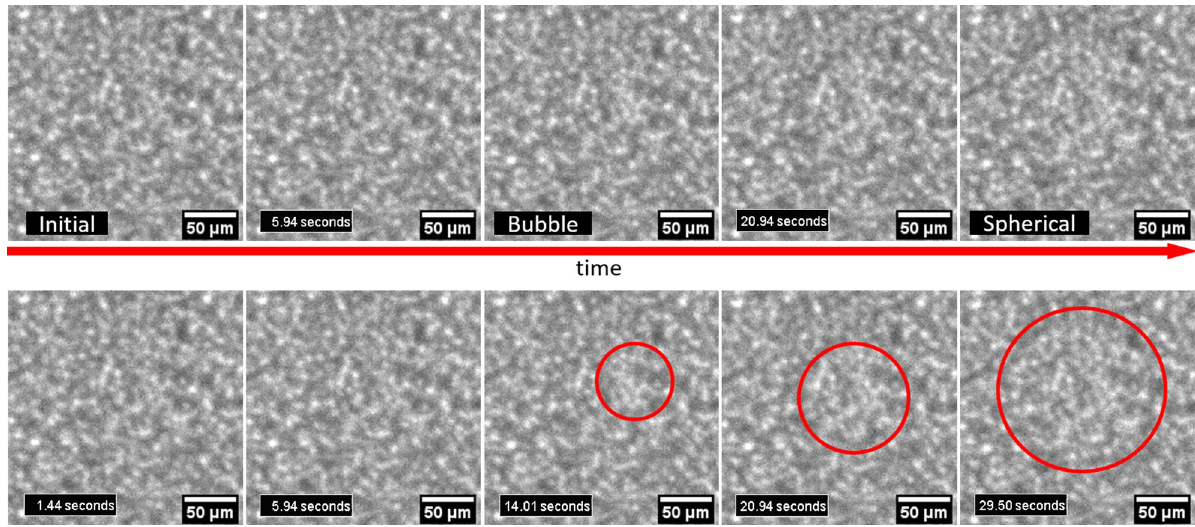
Figure 5. X-ray images from different times during the irradiation of a sludge-filled cuvette showing the same bubble forming. The images start from the earliest image on the left to increasingly later images on the right (1.4 s, 6 s, 14 s, 21 s, and 29.5 s with respect to the start of irradiation). The central panel shows the early signs of bubble formation around 15 s into the irradiation and the final panel shows the bubble has become spherical around 30 s into the irradiation. On the second row the images are reproduced with the approximate area considered to be occupied by the bubble marked in red to guide the eye. All images were of the same irradiation location and at the same scale. Figure made with images processed by FIJI 56